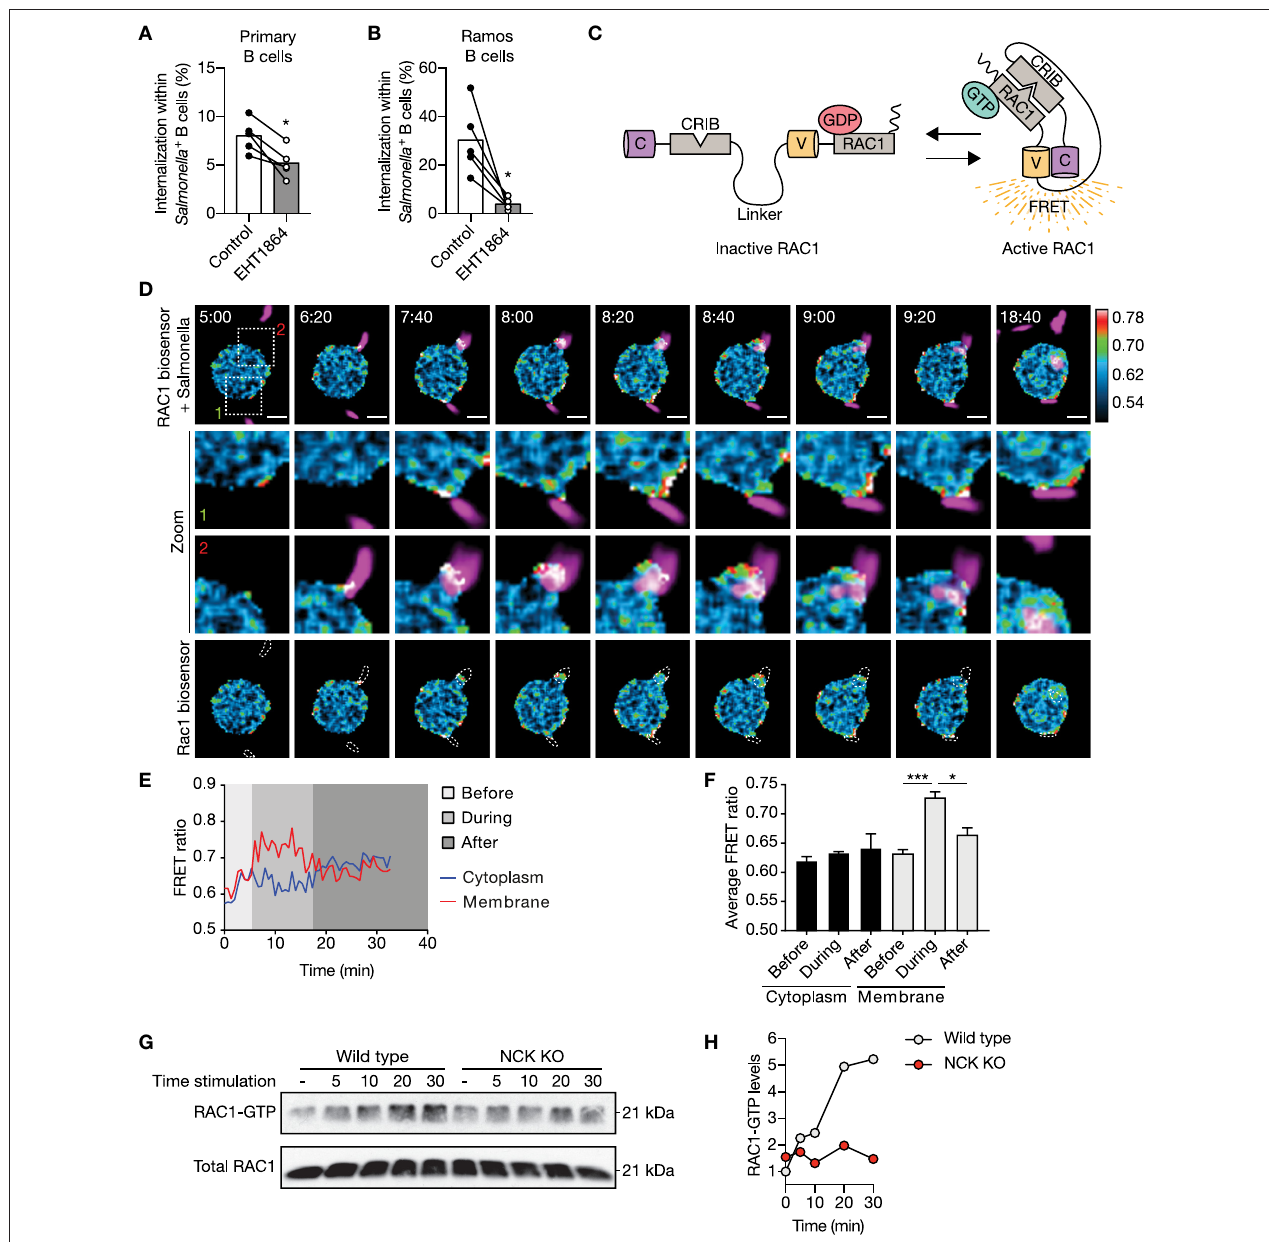
FIGURE 5 | NCK facilitates IgM-BCR-mediated activation of RAC1 subsequent large particle binding. (A,B) Proportion of internalization within S. typhimurium + primary human B cells (A) and Ramos B cells (B) after treatment with a RAC1 inhibitor ( n = 5). (C) Schematic illustration of the Cerulean3-CRIB-Venus-RAC1 FRET sensor. Inactive GDP-bound RAC1 results in a large distance between the two fluorescent proteins without a FRET signal. Active GTP-bound RAC1 binds the CDC42/RAC1-interactive binding (CRIB) motif of PAK1, which brings the two fluorescent proteins into close proximity resulting in high FRET efficiency. (D) Time-lapse Venus/Cerulean3 ratio images of the RAC1 DORA biosensor showing spatiotemporal RAC1 activation upon stimulation with anti-IgM-coated S. typhimurium expressing dsRed (magenta). Bar, 5 µ m. The boxed region at the upper panel is enlarged at the middle panels. Lower panels show RAC1 biosensor FRET ratio images with dashed lines marking S. typhimurium localization. Time indicated in minutes. Calibration bar shows RAC1 activation (red) relative to basal RAC1 activity (blue). (E,F) Representative activation ratio (E) and quantification (F) of the RAC1 biosensor in time. The activation ratio was assessed at the membrane as compared to the cytoplasm in close proximity to the particle contact area before, during and after S. typhimurium internalization ( n = 3 independent experiments). (G,H) Immunoblot and quantification of GTP-bound RAC1 precipitated from whole cell extracts of wild type and NCK KO Ramos B cells that were unstimulated ( − ) or stimulated with anti-IgM-coated S. typhimurium for 5, 10, 20, and 30min. Total Rac1 levels from whole cell extracts were determined to control precipitation input (representative of n = 2 independent experiments). Bars depict mean values and error bars are SEM. Each data point represents the mean of an individual experiment with duplicate measurements. * P < 0.05; *** P < 0.001 by paired t -test.